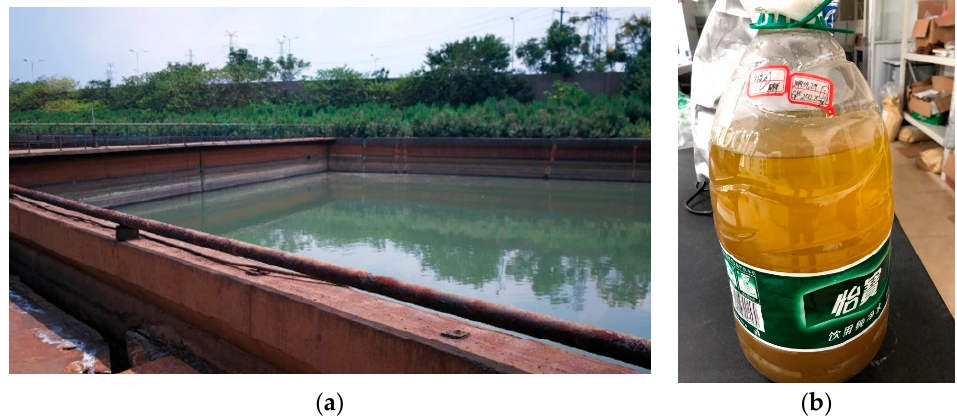
Figure 1. Sampling site and wastewater sample. ( a ) Sewage treatment tank; ( b ) the sample of untreated wastewater.